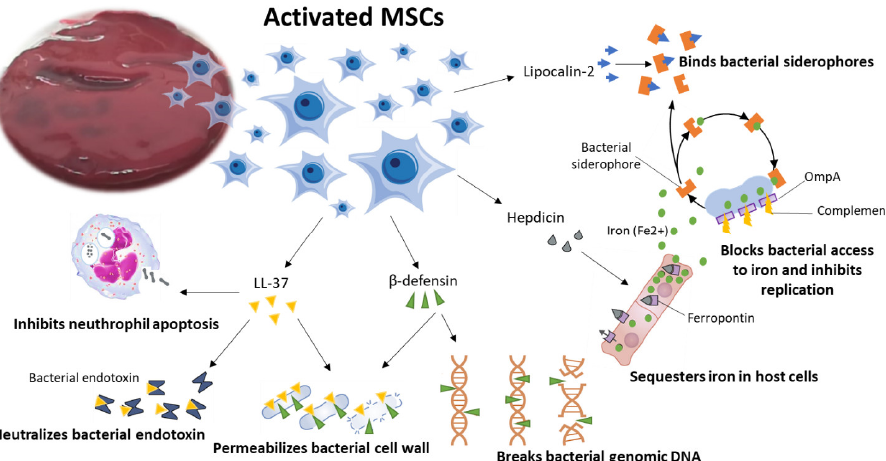
Figure 1. Schematic representation of potential direct antimicrobial activity of BM clot MSCs. Adapted from Shaw et al. [21] by GIMP 2.10.32 software.